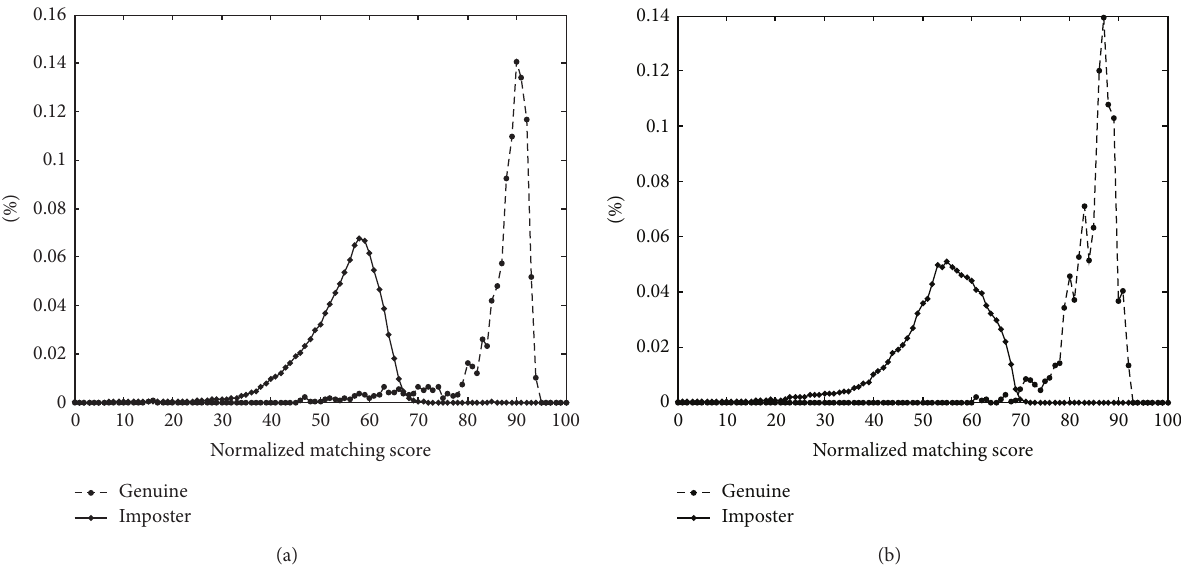
Figure 5: Distributions of genuine and imposter matching scores; vertical axis represents distribution of matching scores in percentage. (a) Distribution of matching scores on OAS1 . (b) Distribution of matching scores on OAS2 .